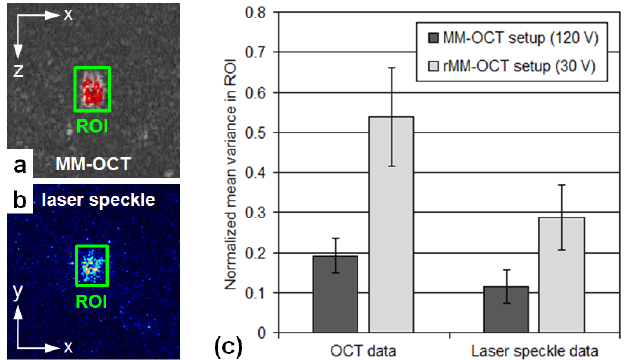
Figure 6. Quantification of the cellular magnetomotive signal using OCT and laser speckle analysis. In each OCT ( a ) and laser speckle image ( b ) a region of interest (ROI) representing the cell is chosen and the mean magnetomotive signal is determined; ( c ) Magnetomotive signals retrieved from OCT data (left column) and laser speckle data (right column) for five different cells imaged with our previous pulsed MM-OCT setup (dark bars) and the novel rMM-OCT setup (bright bars) using a capacitor charging voltage of 120 V and 30 V, respectively. The magnetomotive signals represent the normalized mean variance in the ROI, i.e., the mean pixel variance divided by the average pixel intensity across the magnetic pulse. Data represents mean values ± standard deviation (color online).